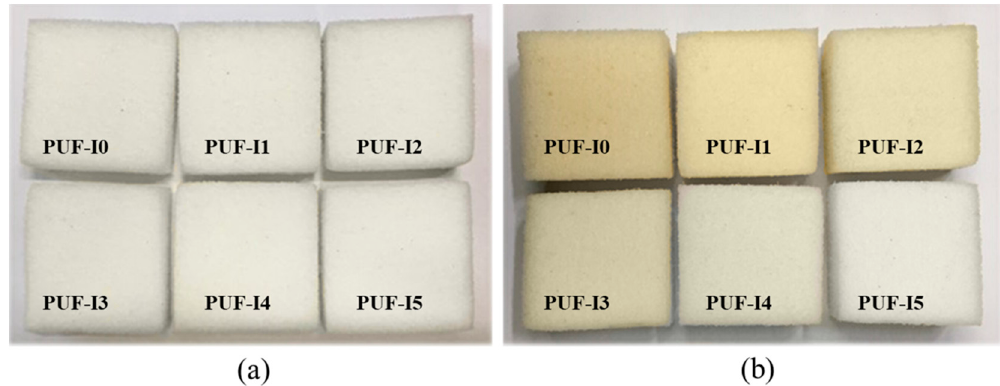
Figure 10. Color comparison of FPUF samples ( a ) before and ( b ) after thermal treatment at 160 °C. Table 5. YI of the FPUFs after thermal treatment at 160 °C.